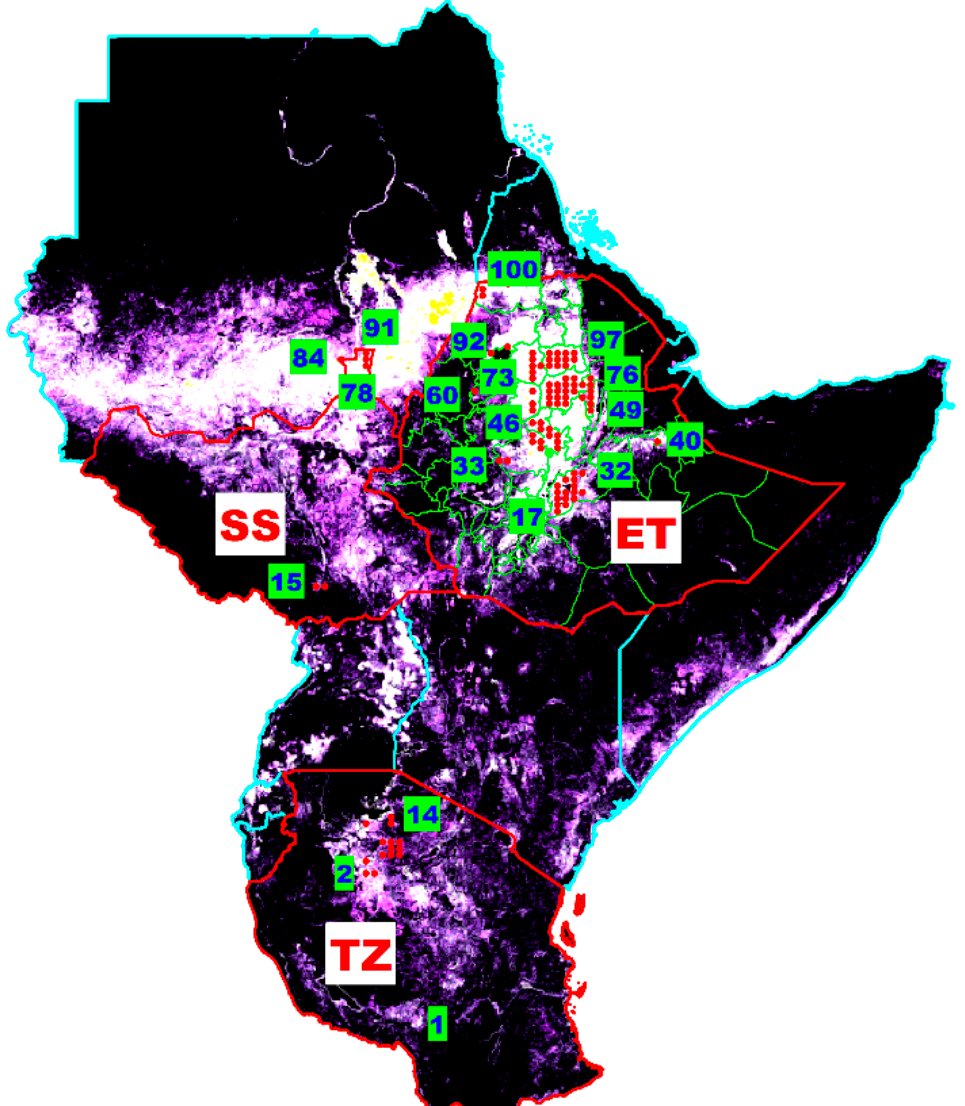
Figure 1. Cropland class stability map in Eastern Africa for 2003–2012. Yellow shows stable core cropland areas; white displays unstable core areas; magenta displays unstable peripheral areas; black shows where croplands do not occur in the study period. Superimposed are 100 AMSR pixels (red dots) selected on dominant cropland areas. Pixels are numbered from S to N and then from W to E (all numbers are not labeled due to space limitations).